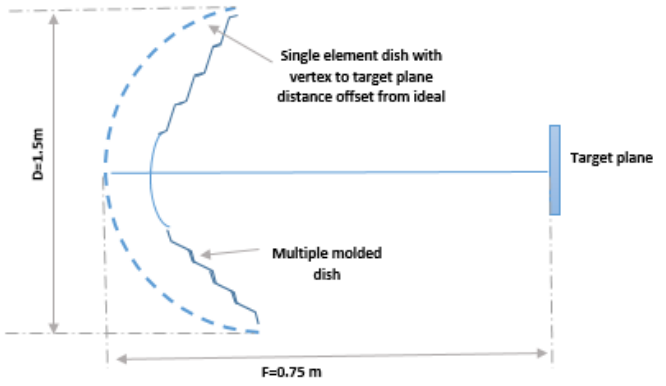
Figure 15. Geometry of a moulded mirror concentrator of five sections.